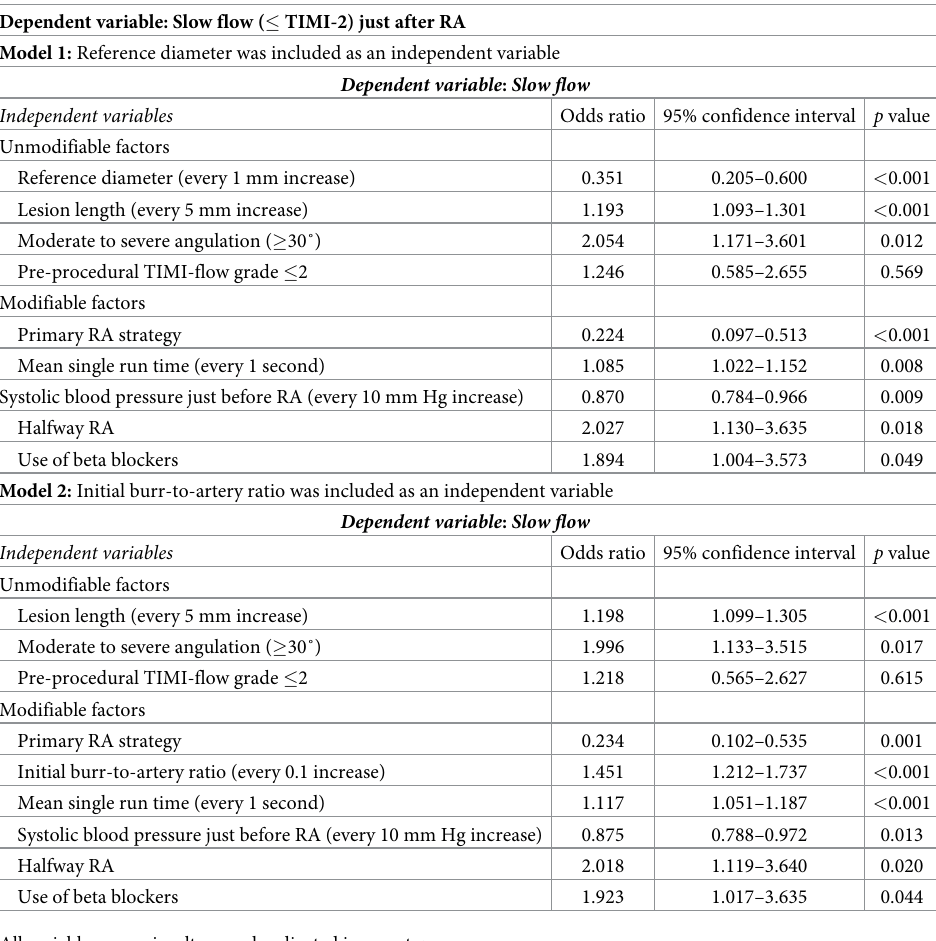
All variables were simultaneously adjusted in one